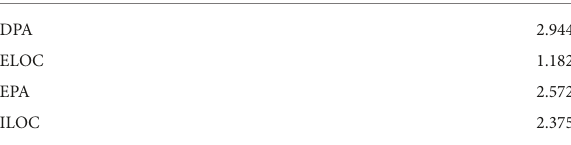
TABLE 2 Inner variance inflation factor (VIF)